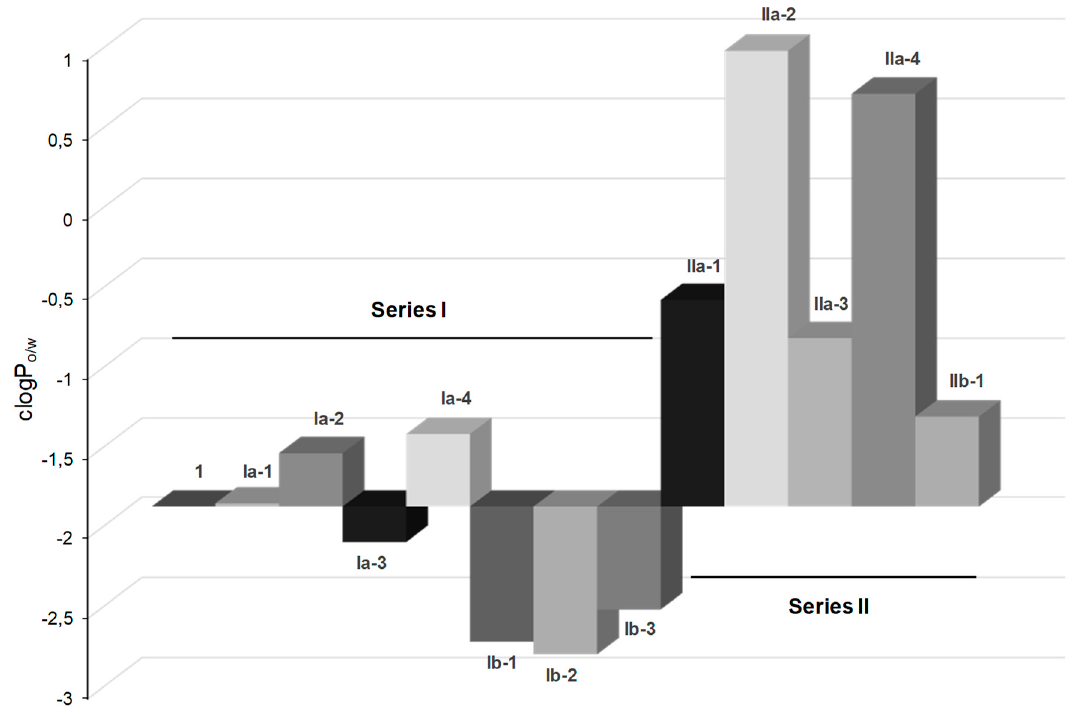
ff erent HOPO-diamine hybrid